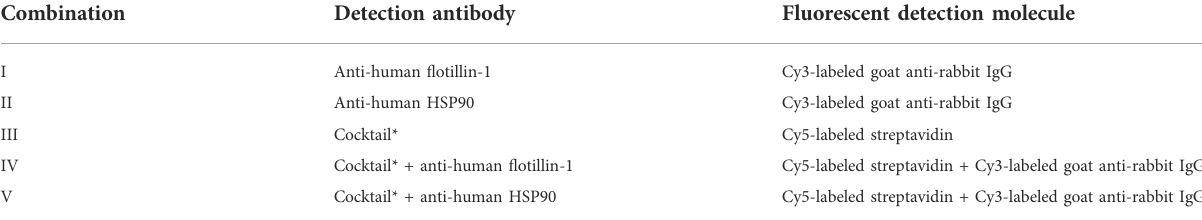
TABLE 1 Five different combinations of detection antibodies and fl uorescent molecules for visualization in the EV Array procedure.